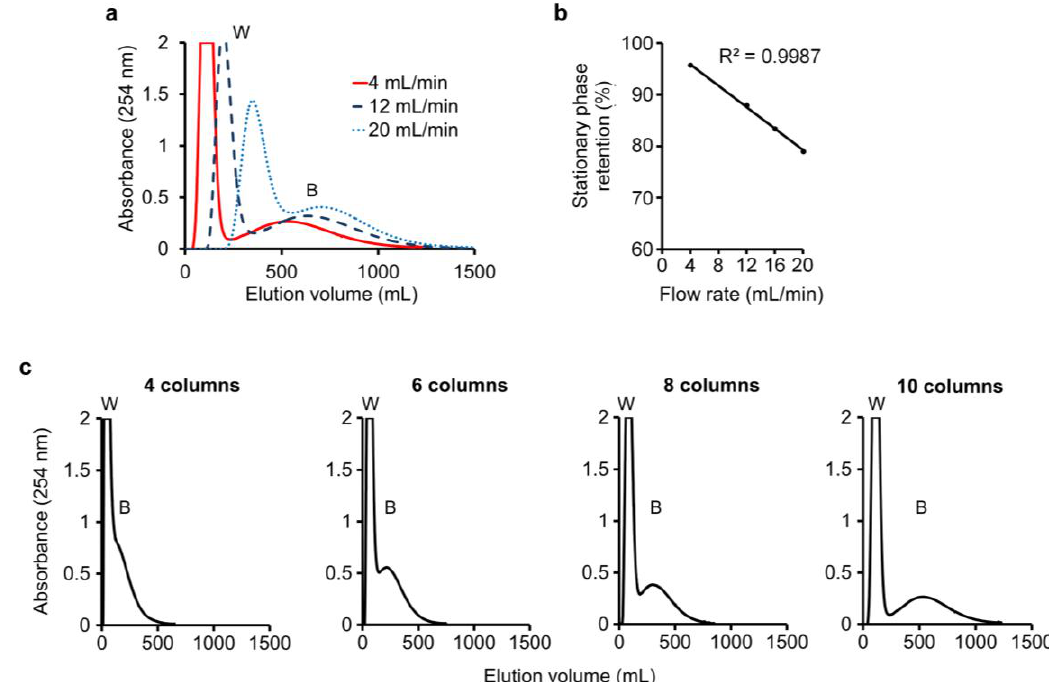
Figure 5. Separation of wogonin and baicalein: ( a ) Separation of wogonin (W) and baicalein (B) in eluate at a flow rate of 4, 12, or 20 mL/min using ten columns; ( b ) Effect of flow rate on stationary phase retention; ( c ) Effect of number of columns on separation.